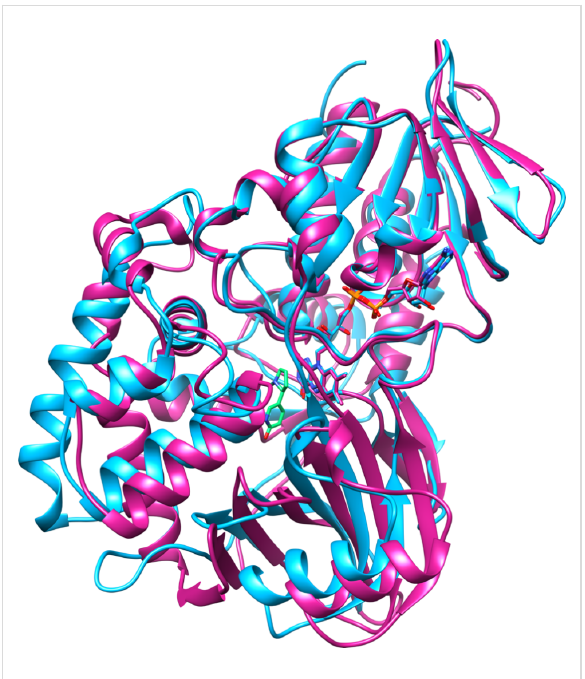
Figure 4: Overlay of the structure of LHNO (magenta, pdb file 3NG7) with that of NicA2 (magenta, pdb file 5ttj) B (green, pdb file 2FXU). The bound 6-hydroxynicotine is shown with green